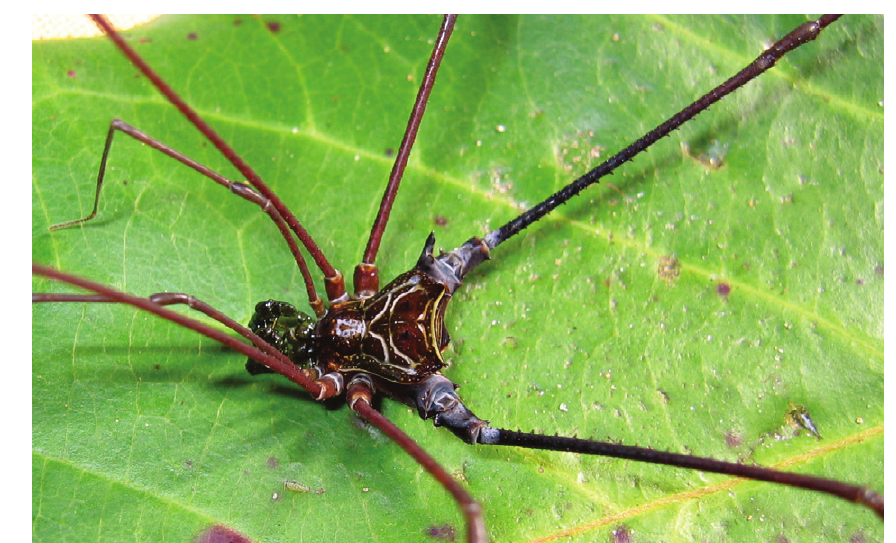
Figure 6. Living male of S. gnaspinii sp. nov. from Barra do Turvo (MZSP 25777